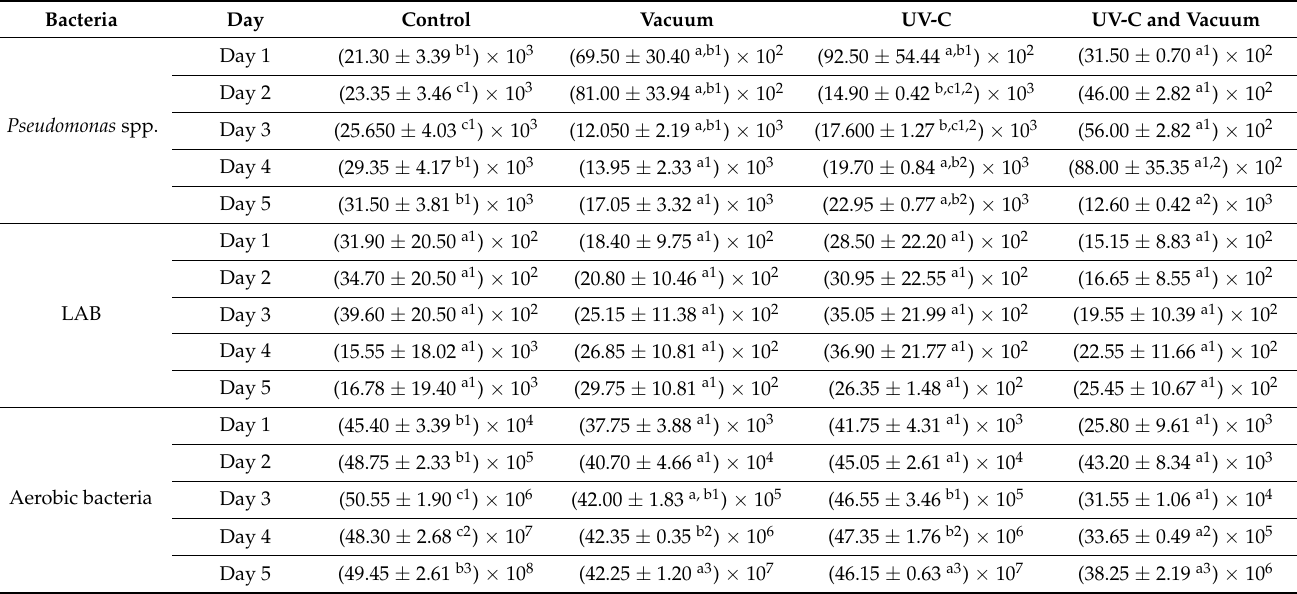
Table 3. The results of the one-way ANOVA analysis and Tukey HSD results, with the mean microbial counts (CFU/g) of the salmon